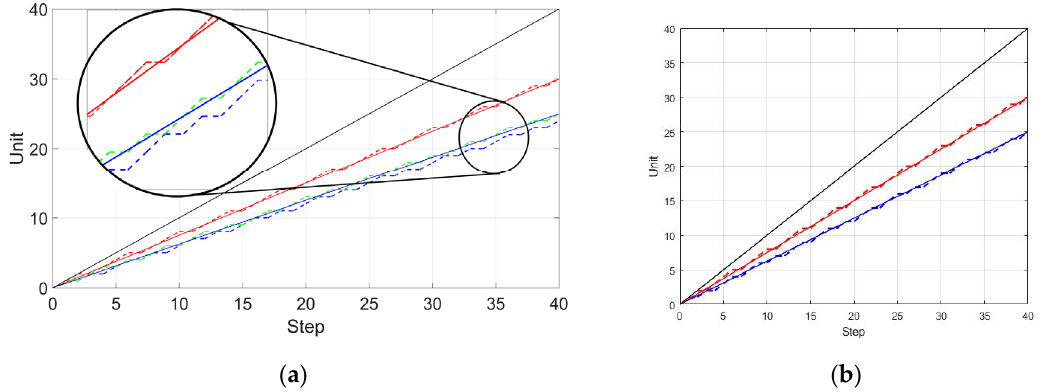
Figure 10. The result of algorithm to generate straight lines. ( a ) Liu’s algorithm keeps one decimal place. ( b ) Algorithm in this article. place. ( b ) Algorithm in this article.